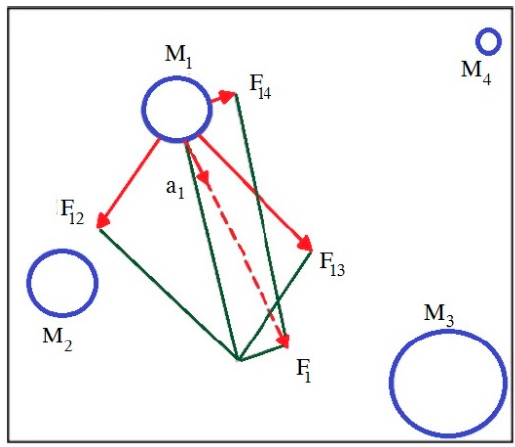
Figure 3. Gravitational search algorithm (Rashedi et al., 2009).